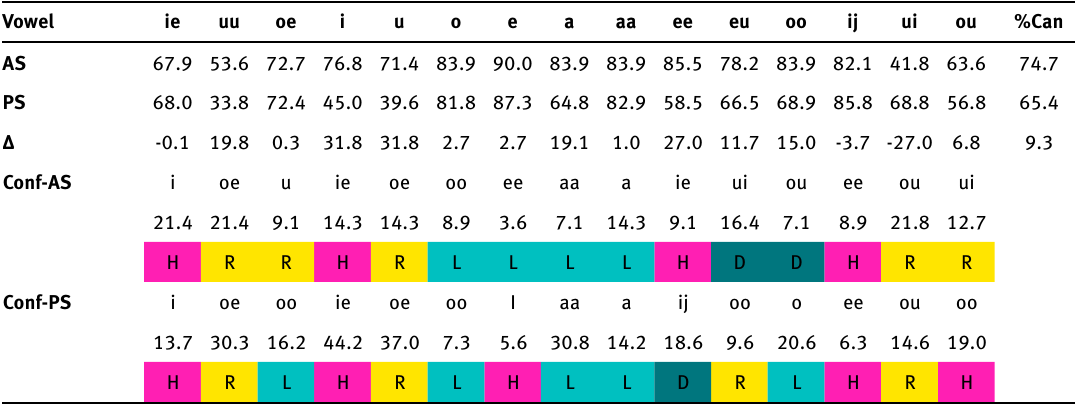
Table 11. Percentages of canonical classifications/transcriptions per target vowel and most frequent vowel confusions, resul- ting from the acoustic and the perception study, confusions related to vowel height (H, in pink), vowel length (L, in turquoise), rounding (R, in yellow) and diphthongization (D, in teal) are also indicated; Vowel = target vowel, AS = acoustic study, PS = perception study, Δ = difference between the percentages of canonical classifications/transcriptions of both studies, Conf-= most frequent vowel confusions per study, %Can = average percentage of canonical